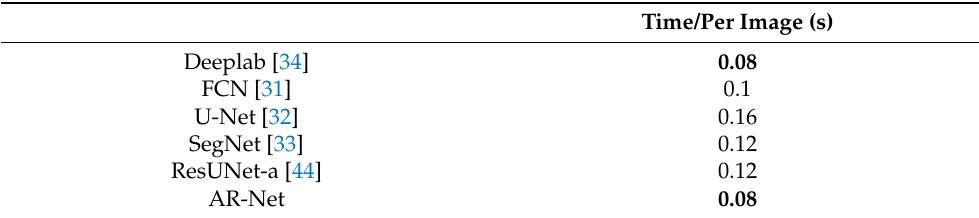
Table 3. The average time consumption of the six semantic segmentation algorithms for the FIO-AR dataset. The bold numbers represent the minimum value in the